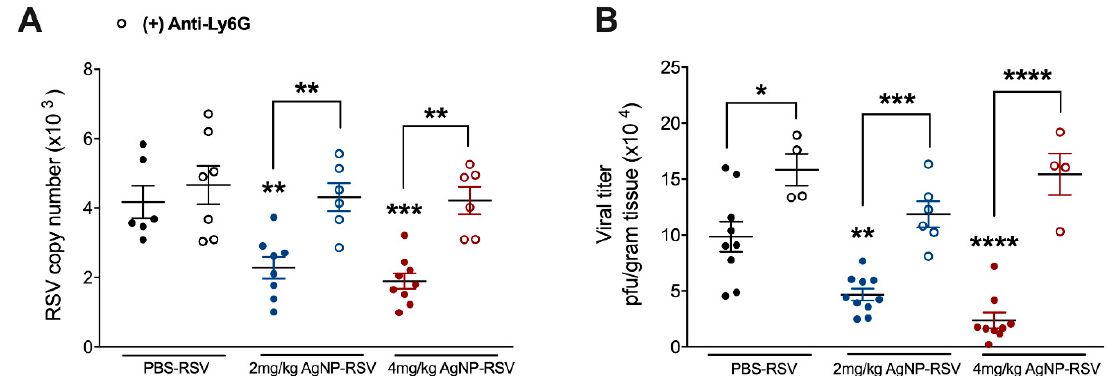
Figure 5. Neutrophil depletion results in a reversal of the antiviral effect noted in neutrophil immunocompetent AgNP-RSV mice. Following injection with anti-Ly6G clone 1A8, lung tissue was collected at day five p.i. for evaluation of ( A ) viral copy number by qRT-PCR and for ( B ) viral titer using lung homogenate in a viral plaque assay. Data are expressed as mean ± SEM (n ≥ 4 mice) and is representative of two independent experiments. Significant results as compared to the RSV control are marked with asterisks, and additional comparisons between groups are indicated with brackets (* for p ≤ 0.05, ** for p ≤ 0.01, *** for p ≤ 0.001, **** for p ≤ 0.0001).